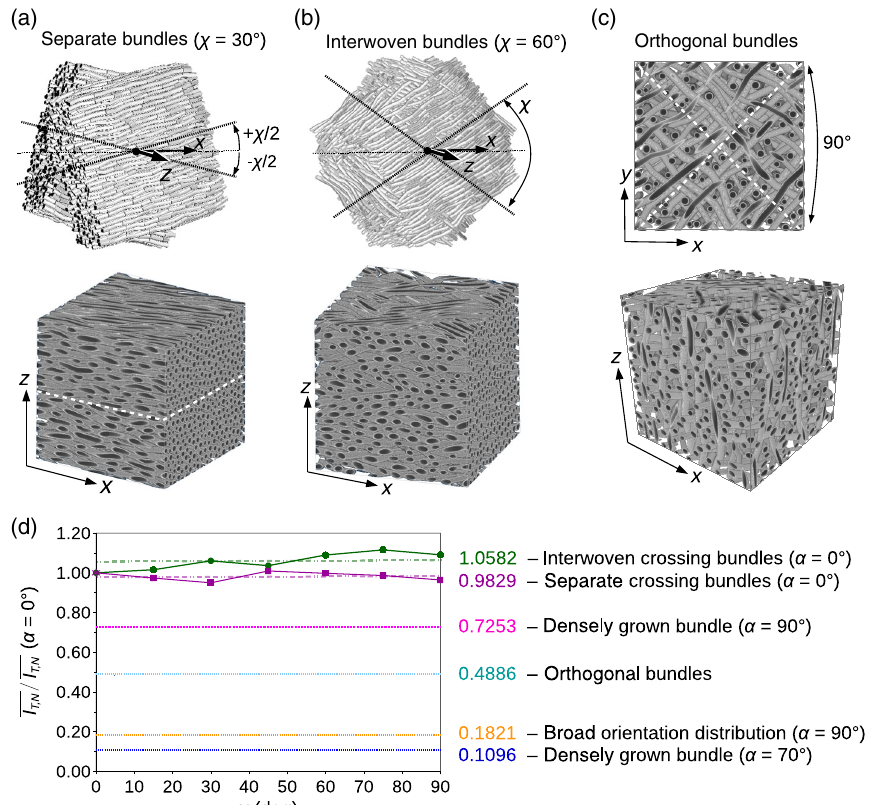
FIG. 5. Simulated transmittance of crossing fibers. (a),(b) Separate and interwoven fiber bundles with crossing angle χ : The upper figures show the generated bundles before cropping. The lower figures show the bundles after being cropped to a volume of 30 × 30 × 30 μ m 3 . The white dotted line indicates the border between the upper and the lower bundle of the separate crossing fibers. (c) Three mutually orthogonal, interwoven fiber bundles cropped to a volume of 30 × 30 × 30 μ m 3 . The white dotted lines indicate the main directions of the two horizontal fiber bundles in the xy plane, and the third fiber bundle is oriented in the z direction. All fiber configurations are generated from 700 fibers with diameters between 1.0 and 1 . 6 μ m. (d) Mean transmittance values for different crossing angles χ shown for in-plane crossing (solid curves) and out-of-plane fiber configurations (densely dotted curves). For better comparison, the values are divided by the mean transmittance value of the corresponding horizontal fiber bundle for χ ¼ 0 °. The mean normalized transmittance values I are computed from a simulated 3D-PLI measurement (with numerical aperture NA ¼ 0 . 15 ). The T;N simulations are performed with the parameters specified in Appendix F, using normally incident light with 550 nm wavelength. Apart from the fiber configurations shown in this figure, the mean transmittance values are also displayed for the bundle of densely grown fibers [see Fig. 3(b)(i)] for α ¼ 70 ° and 90° and for a vertical fiber bundle with broad fiber orientation distribution [see Fig. 3(b)(ii)]. The mean transmittance is mostly independent of the crossing angle and larger than the mean transmittance of out-of-plane